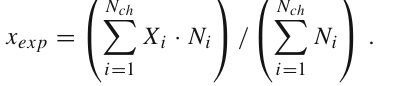
Y i − y 0 = 0, i.e. when the projection of the interaction point is in the center of the